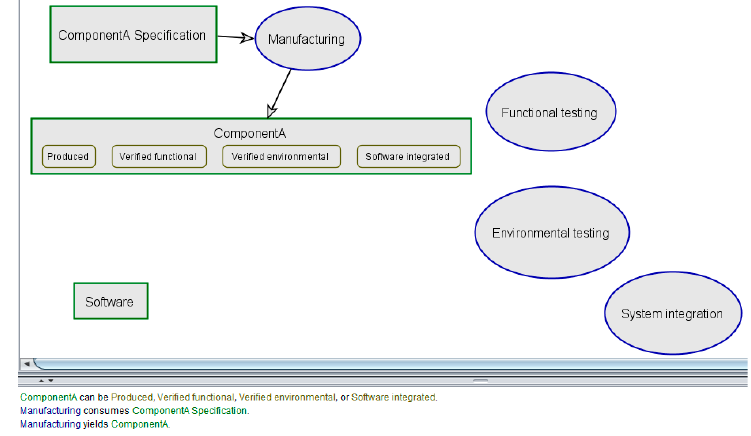
Figure 4. Linking objects and process, option #3.